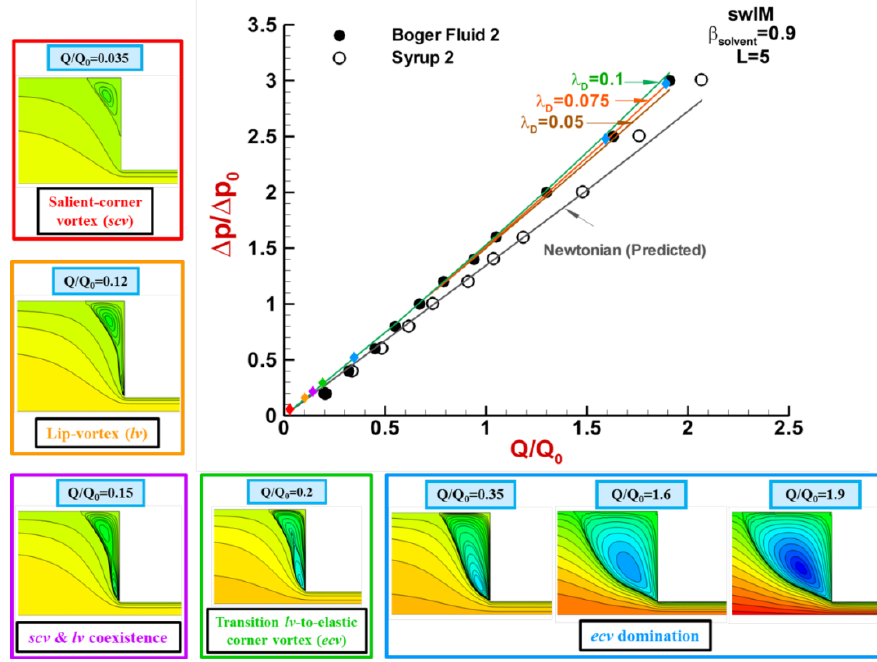
 = {0.0, 0.075, 0.1};  ≤ 0.9, Figure 5. Pressure and streamlines against flow-rate; swIM model; λ = {0.0, 0.075, 0.1}; β ≤ 0.9, L = 5. D D